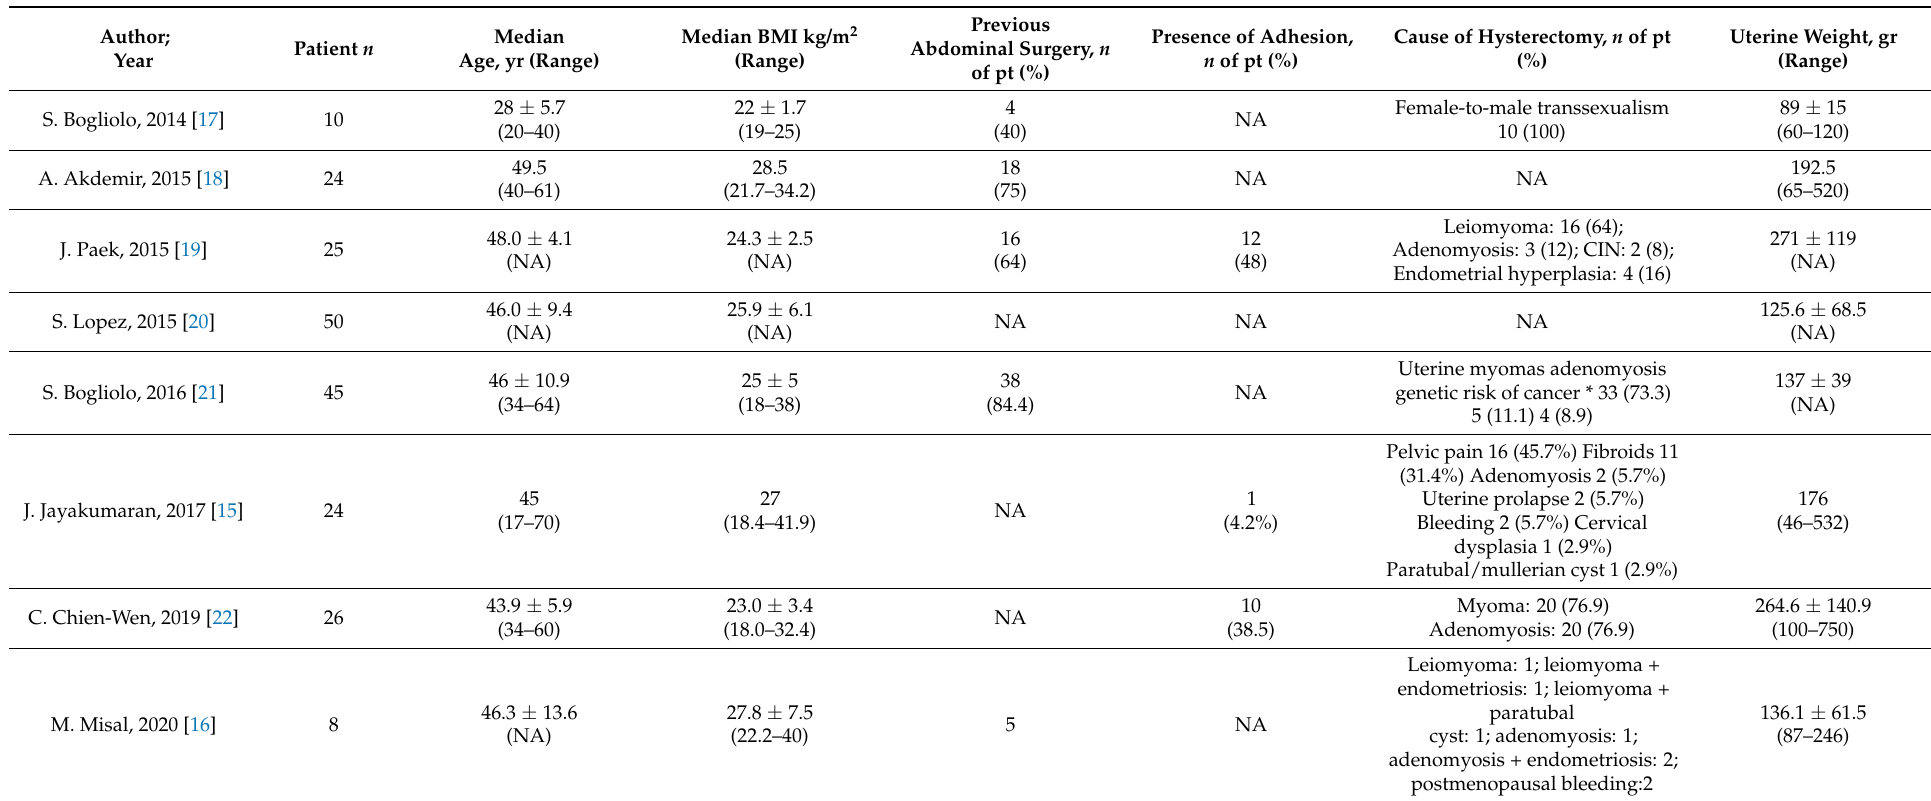
Table 2. Clinical characteristics of